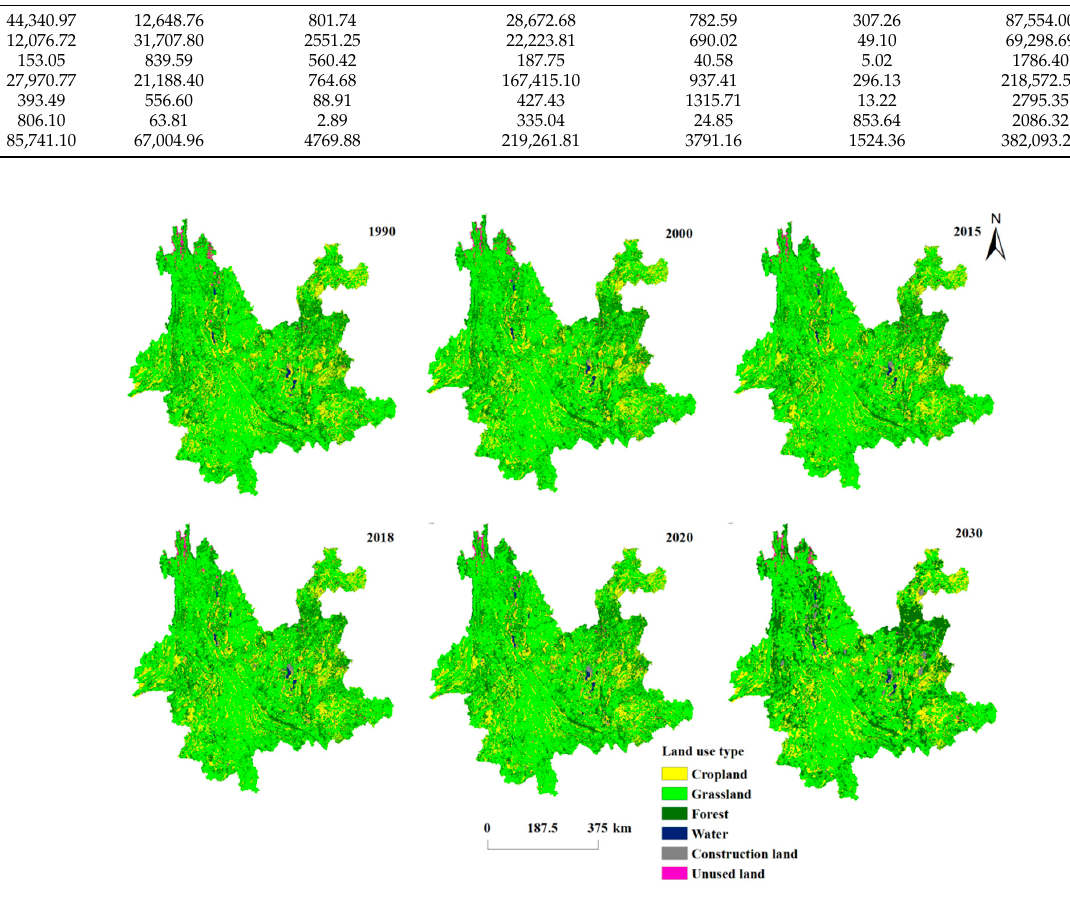
Figure 2. Spatial distribution of land use types in Yunnan Province, 1990–2030.